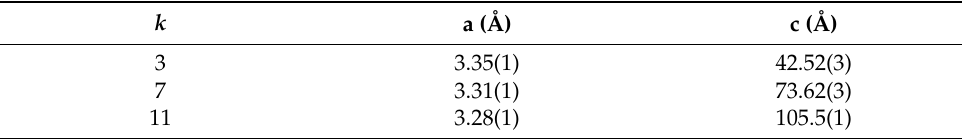
Figure 2. XRD patterns of the prepared IZO samples. ( a ) k = 3, ( b ) k = 7, and ( c ) k = 11. The most intense diffraction maxima have been indexed. Table 1. Lattice parameters obtained by XRD for k = 3, 7, and 11